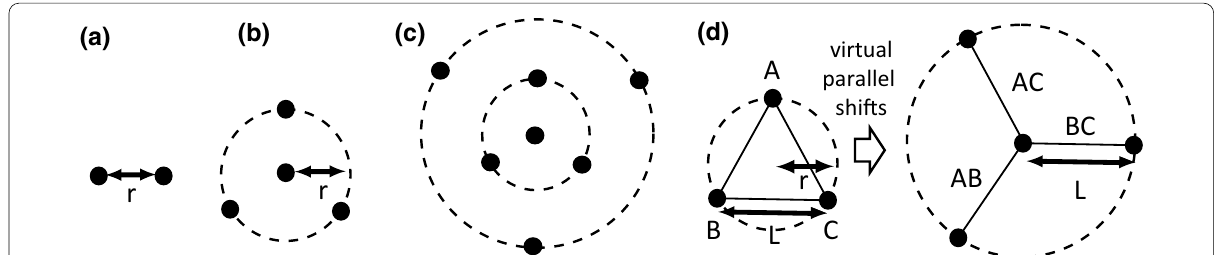
Fig. 2 Microtremor arrays. The solid circles represent seismic sensors. a Two-point array. b Triangular array. c Double triangular array. d Concept of virtual parallel shifts of seismic-sensor pairs with the side lengths regarded as the